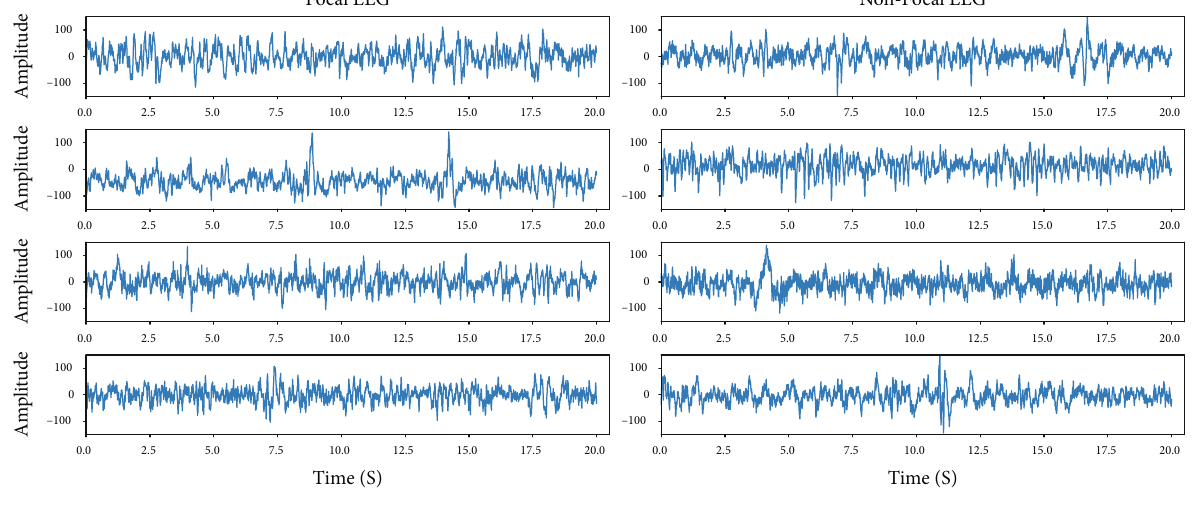
Figure 1: An example of the focal and nonfocal iEEG signal.